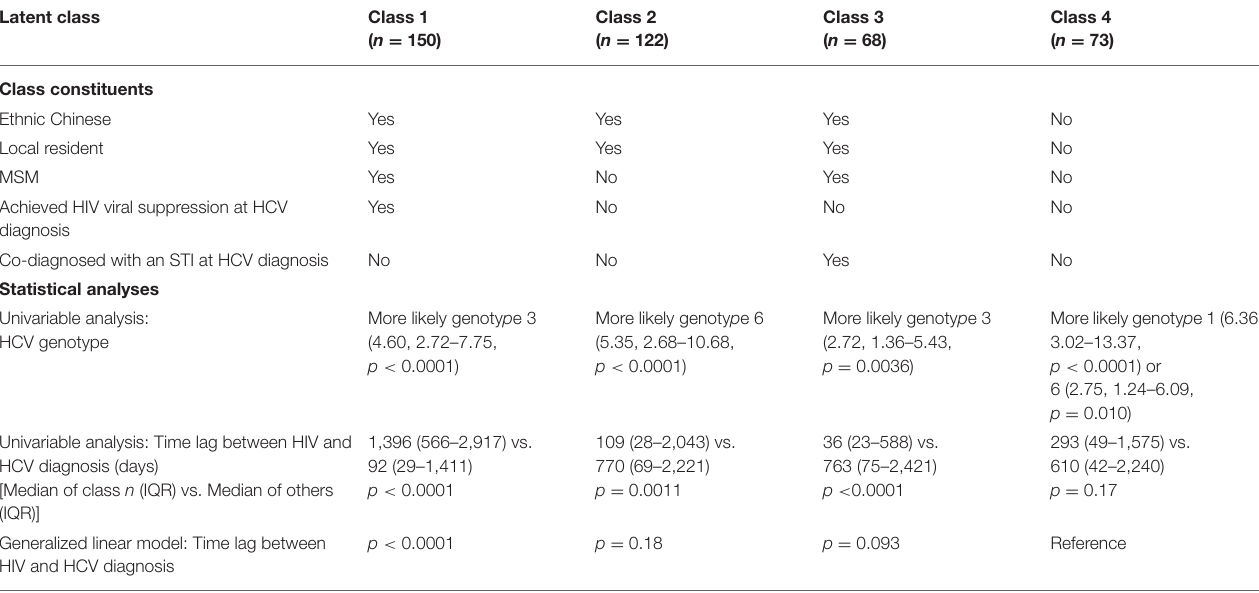
TABLE 3 | Latent class